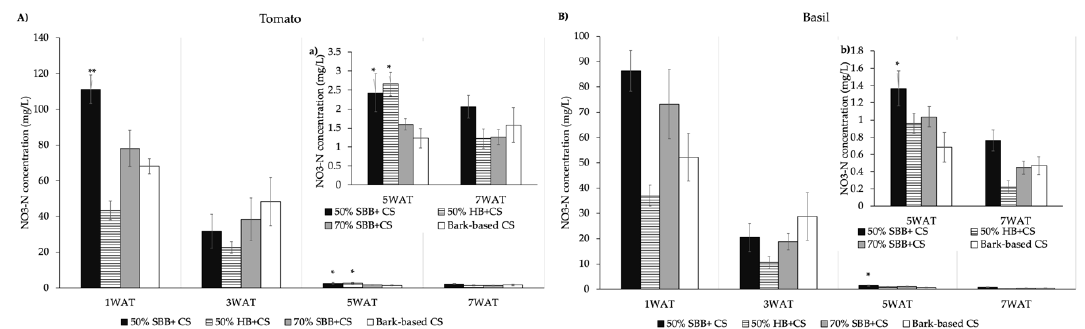
Figure 3. Leachate NO 3 –N (mean ± standard error) of tomato ( A ) and basil ( B ) plants grown in container mixes with 50% (by vol.) sugarcane bagasse biochar (SBB), 50% mixed hardwood biochar (HB), and 70% SBB mixed with bark-based commercial substrate (CS). ( A , B ) Amplified figure for tomato ( a ) and basil ( b ) from 5 WAT to 7 WAT. *, **indicated significant differences from CS using Dunnett’s test at p ≤ 0.05 and p ≤ 0.01, respectively.